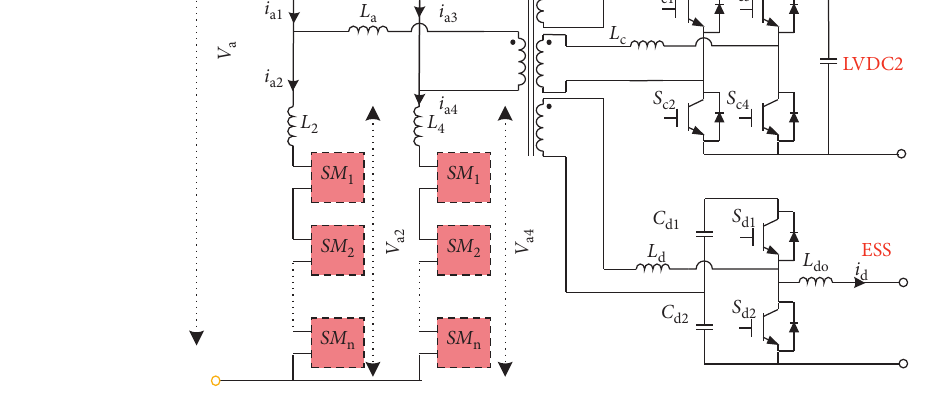
Figure 1: QP-M 2 DC topology.